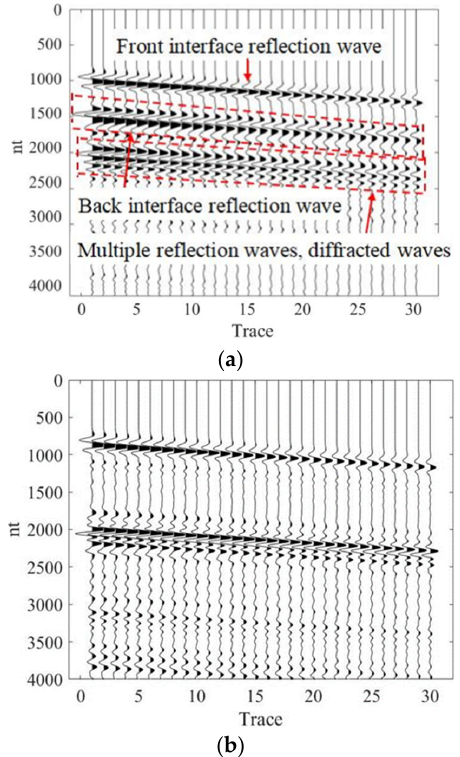
Figure 11. ( a ) Seismic records of CSP gathers of 10 m karst cave numerical model in underside wall. ( b ) Seismic records of CSP gathers of 30 m karst cave numerical model in underside wall.